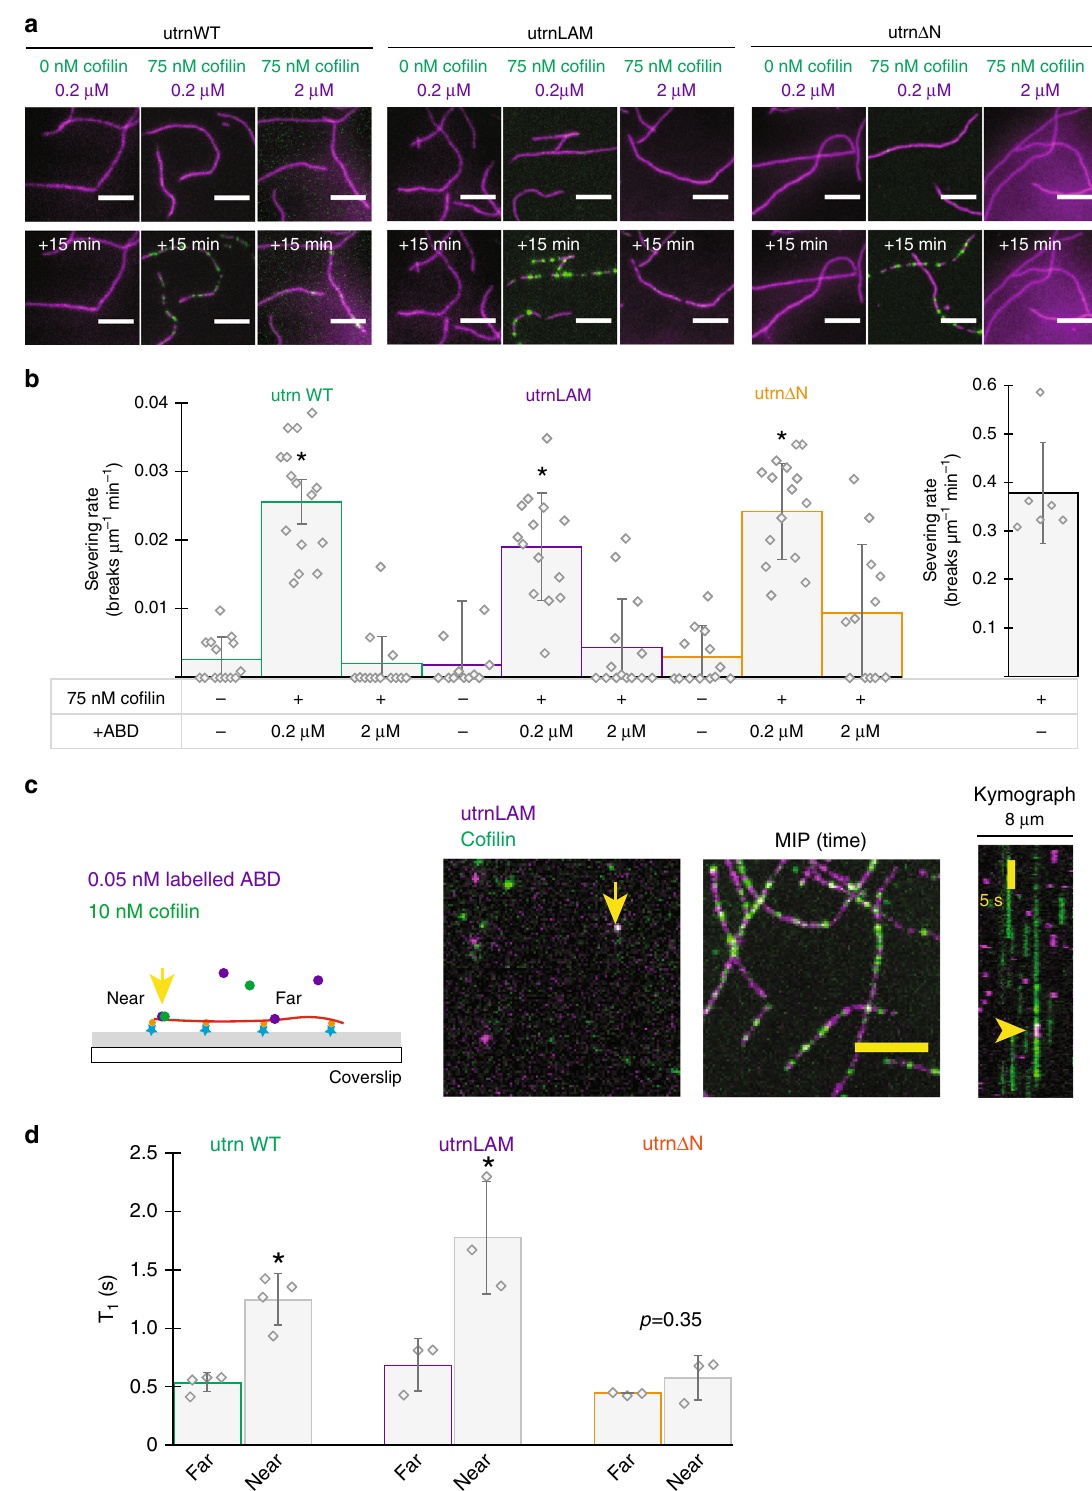
Fig. 4 Filament binding by co fi lin alters utrophin ABD mutant dwell times. a Actin fi lament severing by 75 nM co fi lin (green) in the presence of 0.2 μ M and 2 µ M of the different utrophin mutants (magenta). Scale bars are 5 µ m. b Quanti fi cation of actin fi lament severing rate. The error bars represent the standard deviation of more than 12 imaging regions collected from two imaging chambers. c Single molecule colocalization and kinetic measurements at low concentrations of co fi lin (10 nM) analysed both near and far from a co fi lin binding event. Scale bar 5 µ m. The kymograph is from an 8 µ m section of fi lament. d The fi rst timescale from the fi t to the CDF for molecules near (<30 nm) and far (>30 nm) from co fi lin for utrn WT, utrnLAM and utrn Δ N. Error bars are the standard deviation around the mean of 3 technical replicates. Conditions were compared using a two-tailed students t -test, with p < 0.05 denoted by a star